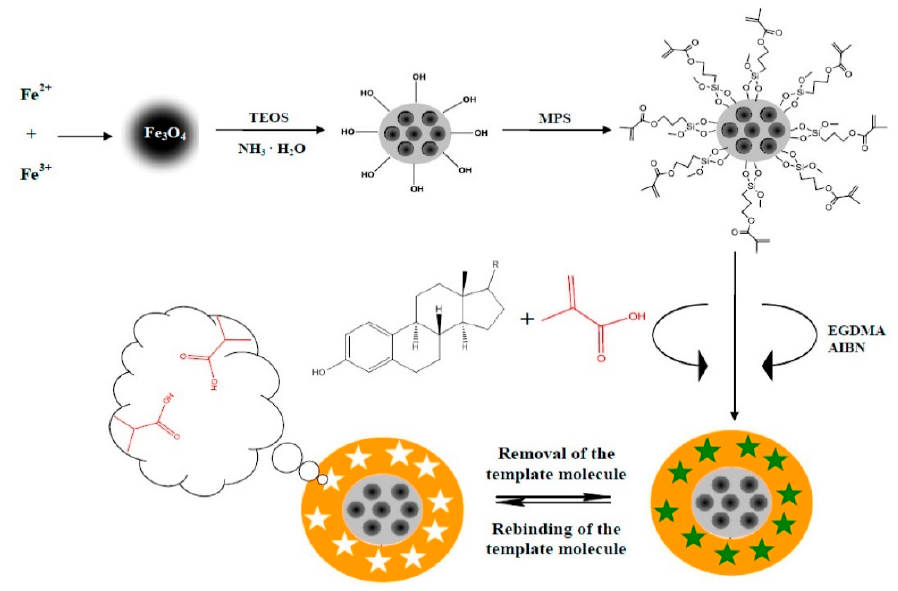
Figure 5. Magnetic MIP–SPE of steroid hormones reported by Guc and Schroeder [64].